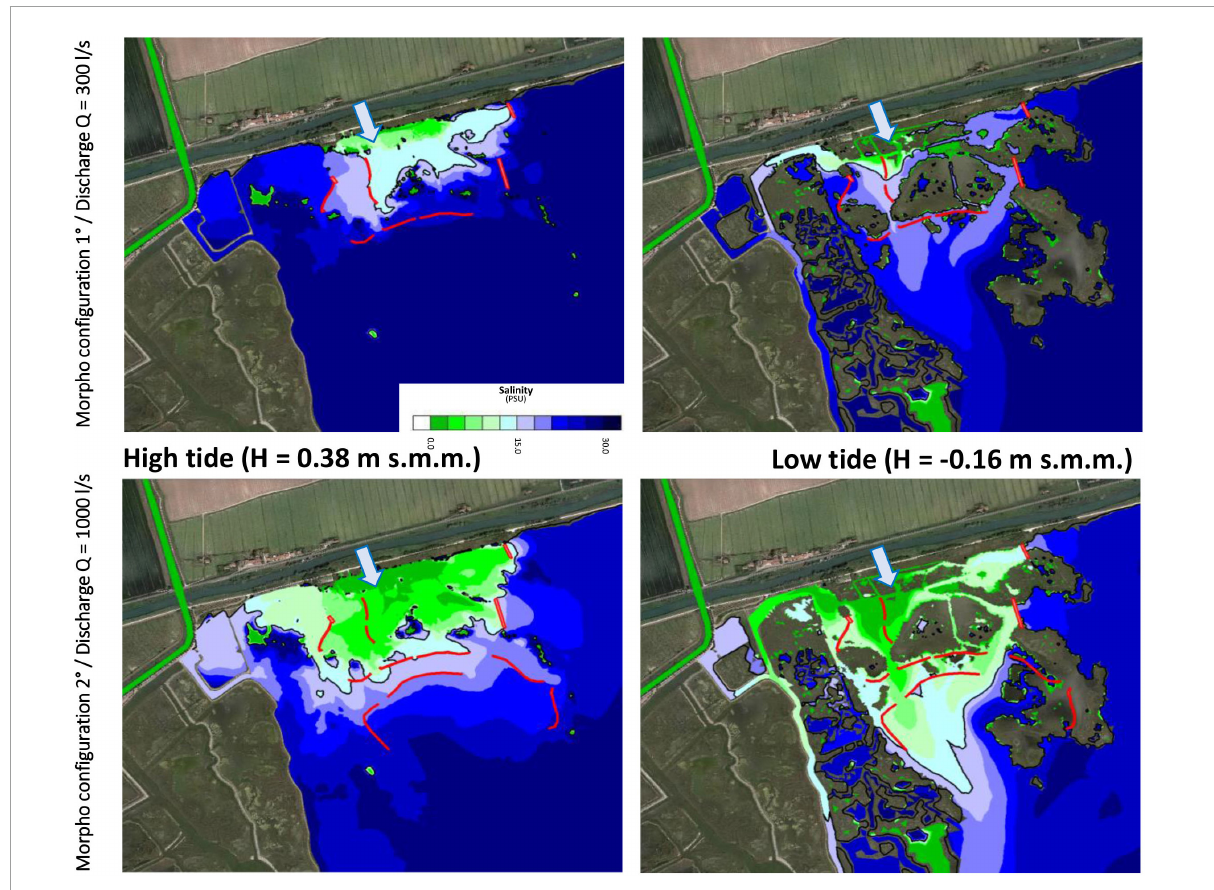
FIGURE3 Maps of salinity distribution in the surface layer (0.08 m above sea level, a.s.l.) with simulations of freshwater displacement in the design phase. Top : with an inflow of 300 l/s and first phase of morphological works. Bottom : with an inflow of 1,000 l/s and second phase of morphological